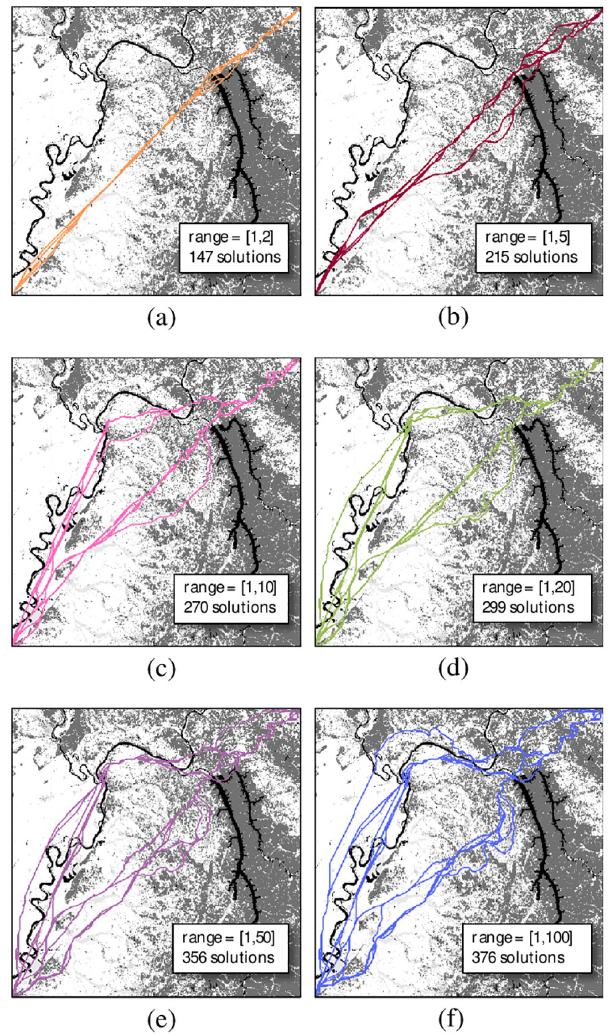
Fig 7. Decision space solutions for a constant C min while varying the amplitude to the following ranges: (a) [1,2]; (b) [1,5]; (c) [1,10]; (d) [1,20]; (e) [1,50]; and (f)